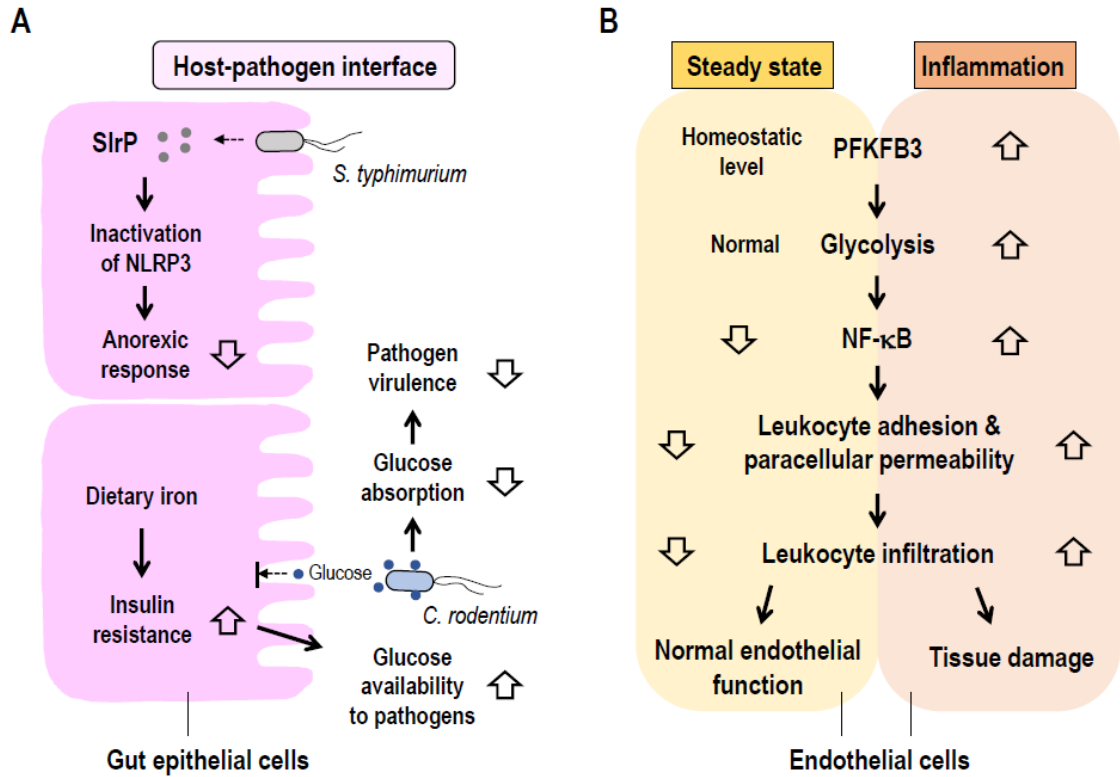
Figure 2. Metabolic regulation at host-pathogen interface and endothelial cells in sepsis. ( A ) Regulated anorexic response and infection tolerance may also emanate from interactions between host and pathogens. S. typhimurium -secreted Salmonella leucin-rich repeat protein (SlrP) involves in epithelial NLRP3 inflammasome inactivation to downregulate anorexic response in host. Host-pathogen metabolic programs ensure adequate supply of nutrients (glucose) to infectious pathogens ( C. rodentium ) at the interface, which result in attenuation of pathogen virulence. ( B ) Endothelial cells heavily rely on glycolysis, in which the glycolytic enzymes 6-phosphofructo-2-kinase/fructose-2,6-bisphosphatase isoform 3 (PFKFB3) plays the key role. In inflammation that causes aberrant activation of PFKFB3, increased glycolysis drives expression of inflammatory mediators, breakdown of the endothelial barrier, and increased extravasation of leukocytes into surrounding tissues. These pathologic events may lead to tissue damage. Upward and downward open arrows indicate increase and decrease, respectively.